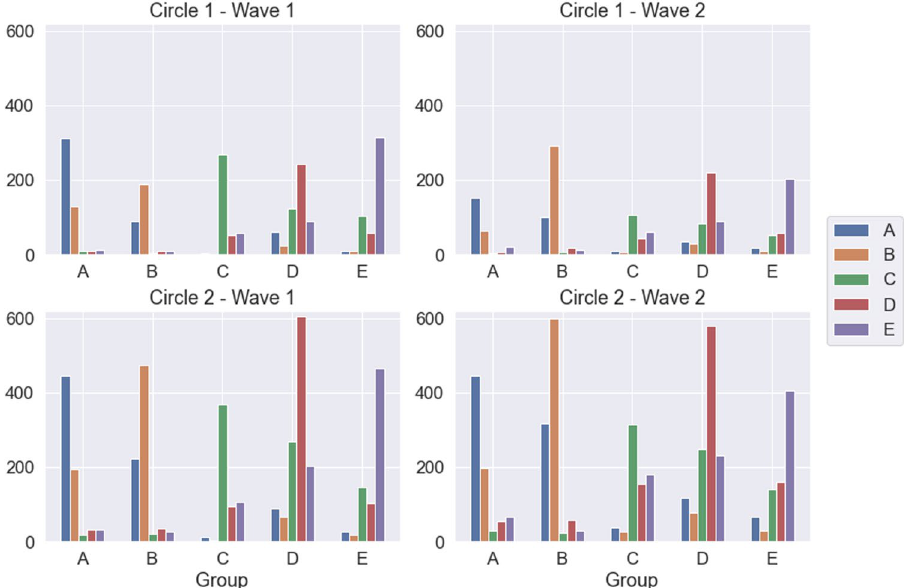
Figure 2. Distribution of relationships among groups. Left: total number of students marked in wave 1, separated by group of the student named. Right: same for wave 2. Top: circle 1. Bottom: circle 2. Colors indicate the group where the students with whom the relationships are reported belong (color code on the right of the figure).